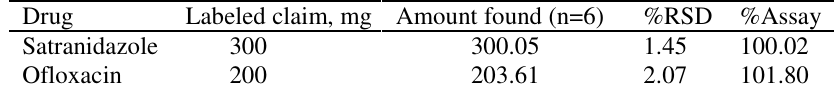
Table 1. Results of assay experiment.